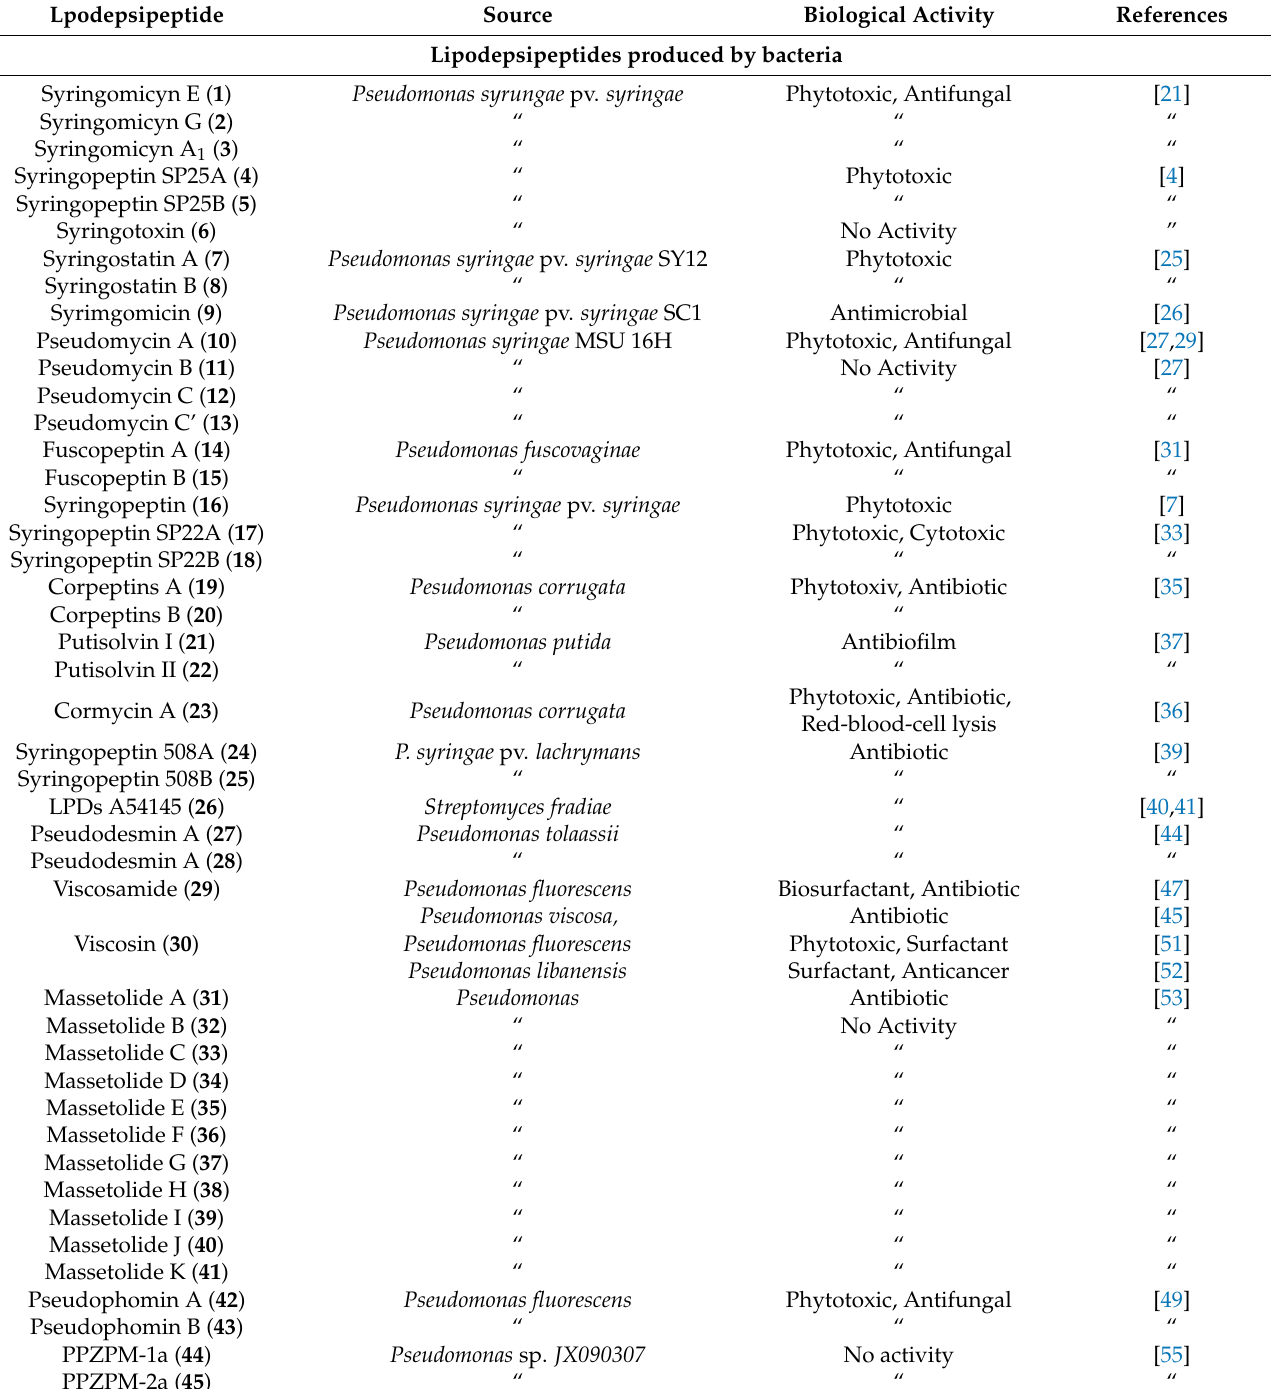
Table 1. Lipodepsipeptides isolated from bacterial and fungi in the last 3